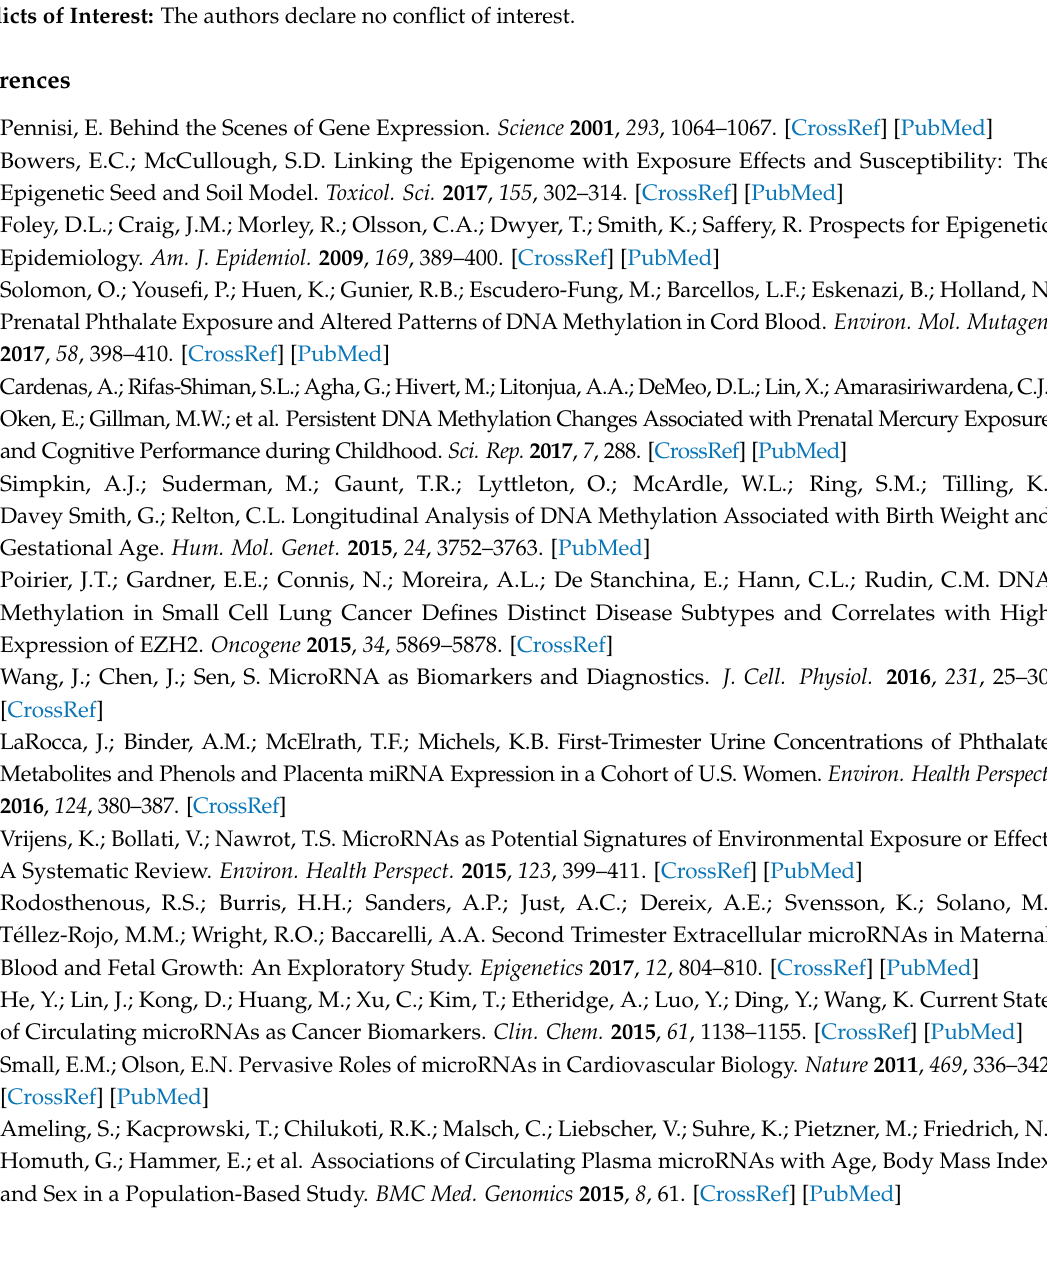
Table S5: Partial correlation of miRNAs between newborns and 7-year-olds, controlling for cell composition. Table S6: Significantly enriched GO terms related to miRNAs differentially expressed between newborns and 7-year-old children. Figure S1: PCA analysis. Cumulative variance explained by each principal